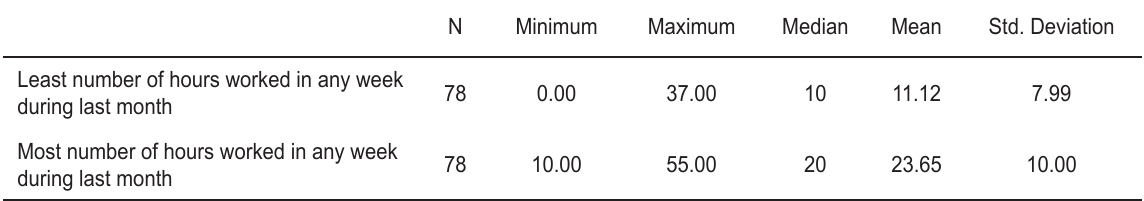
Table 1: Least and most number of hours worked in any week during the last